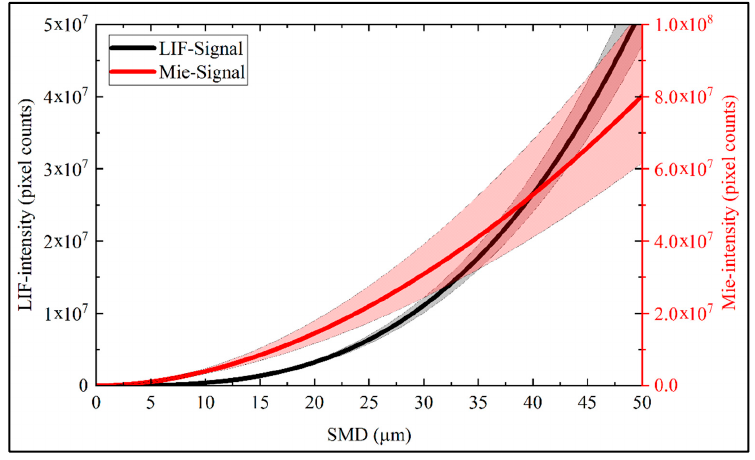
Figure 4. Fitting curves for the experimental microscopic data for LIF and Mie signals as a function of the droplet diameter at the reference condition (293 K, nile red 100 mg/l) with their corresponding standard deviations (Toliso).